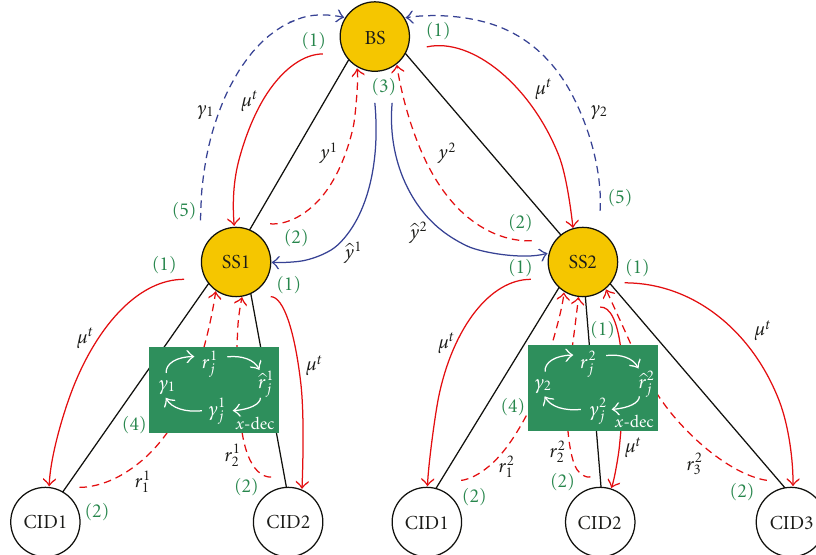
Figure 4: 2-level flow allocation